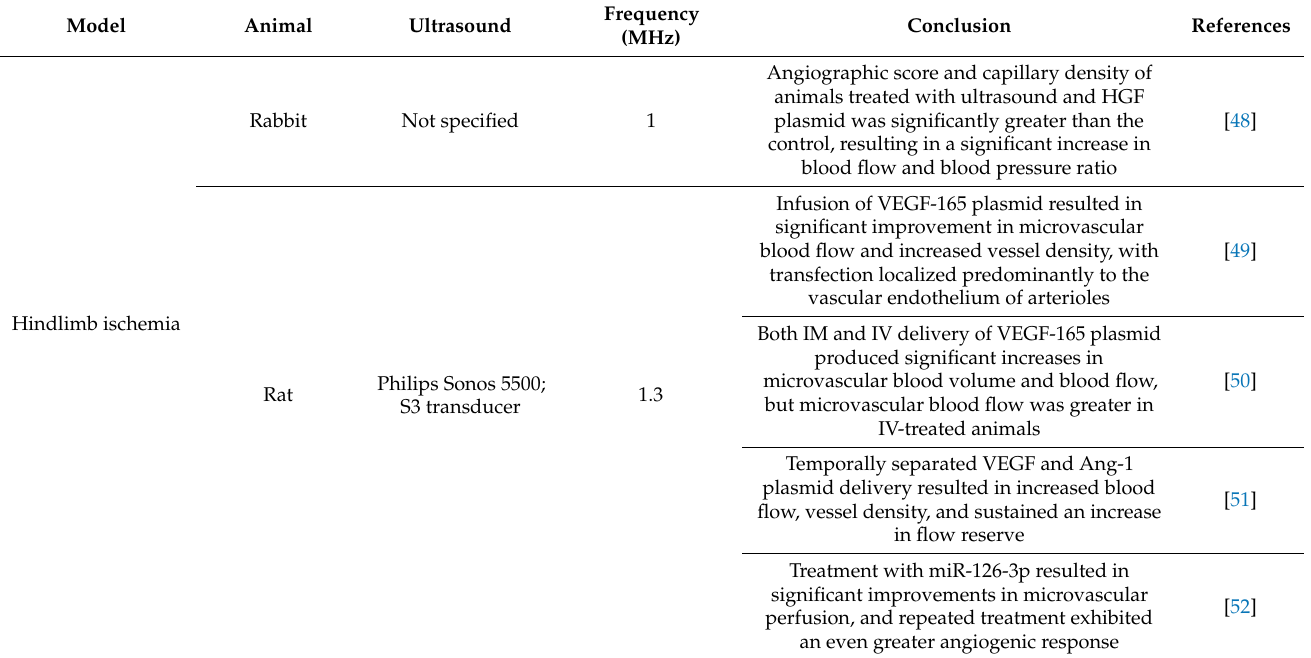
Table 5. The use of sonoporation for ischemia in peripheral